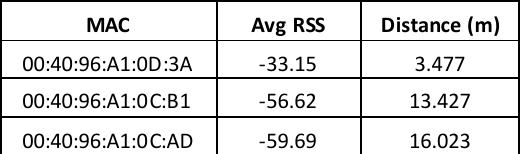
Table 3 – Computed the distance away from each AP from the user measured RSS